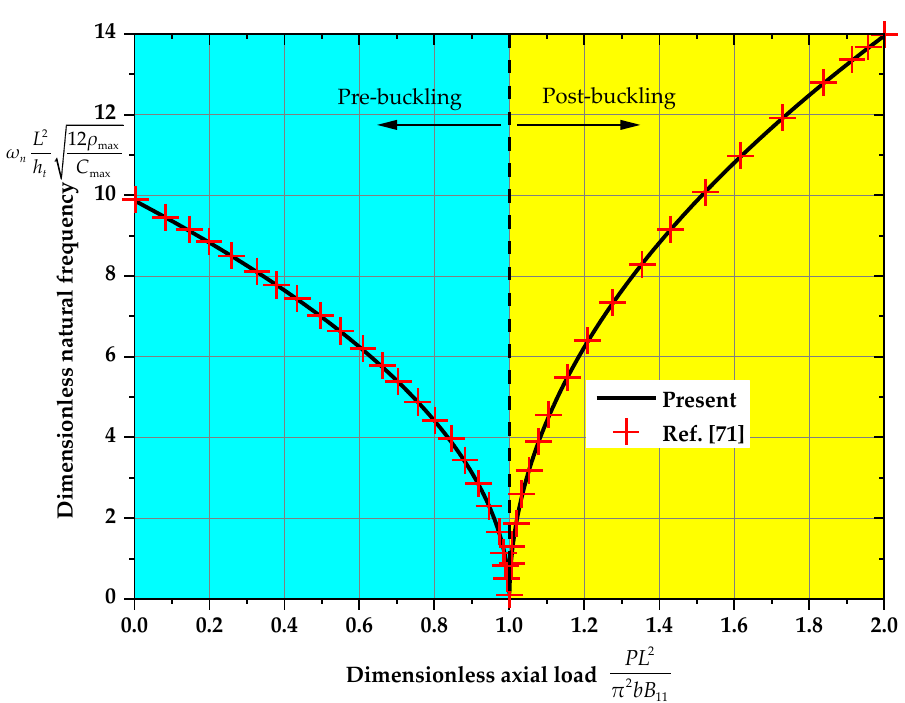
(cid:1)(cid:112) (cid:0) ω n L 2 / h t 12 ρ max / C max ) with the ( ) with the / ( ) bB π PL ) compared with Ref. [71] . 11